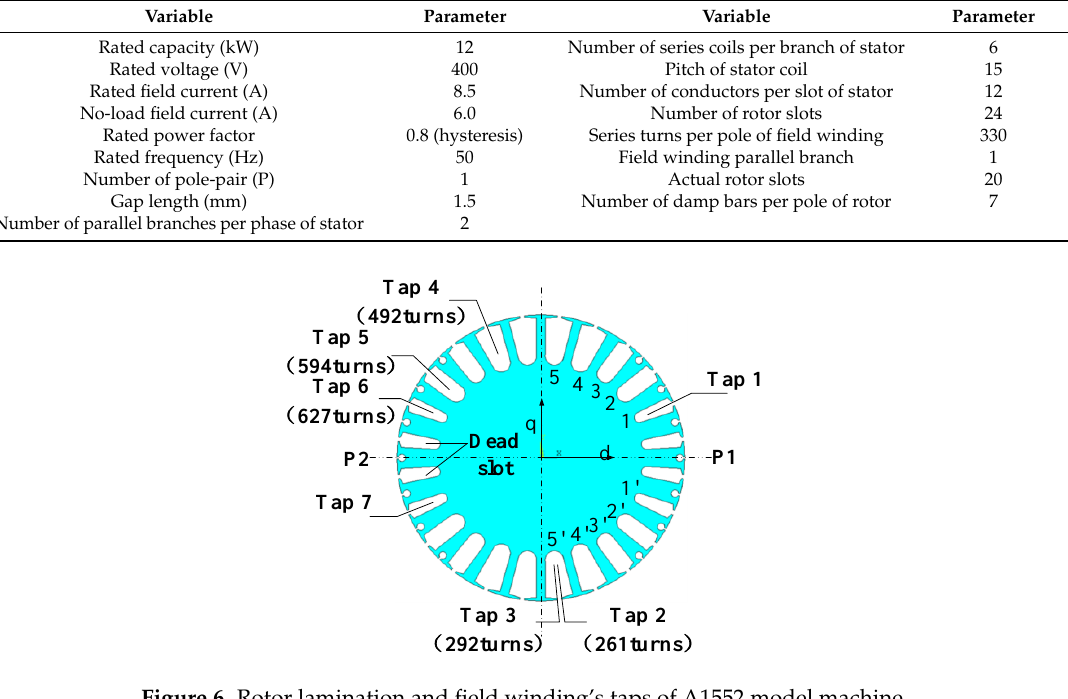
Table 2. Different harmonics root mean square (RMS) of steady state current under inter-turn circuit of taps 2–4 under load condition connected to power grid. Each Harmonic of the Steady State Electrical Quantities